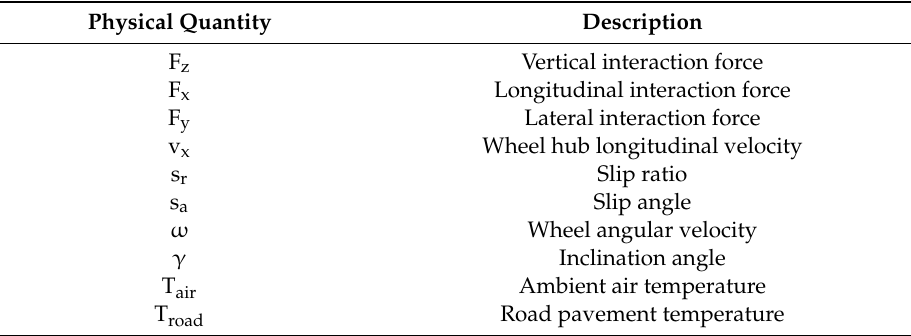
Table 1. thermoRIDE model